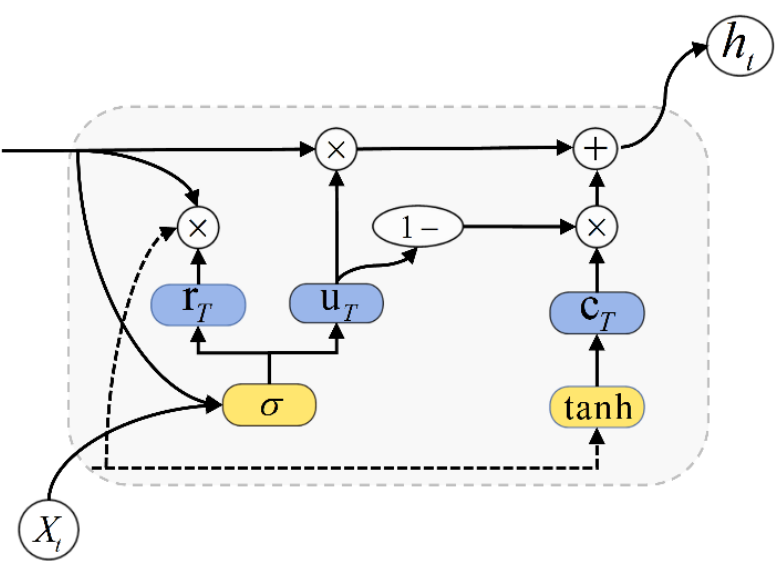
Figure 6. GRU network structure.